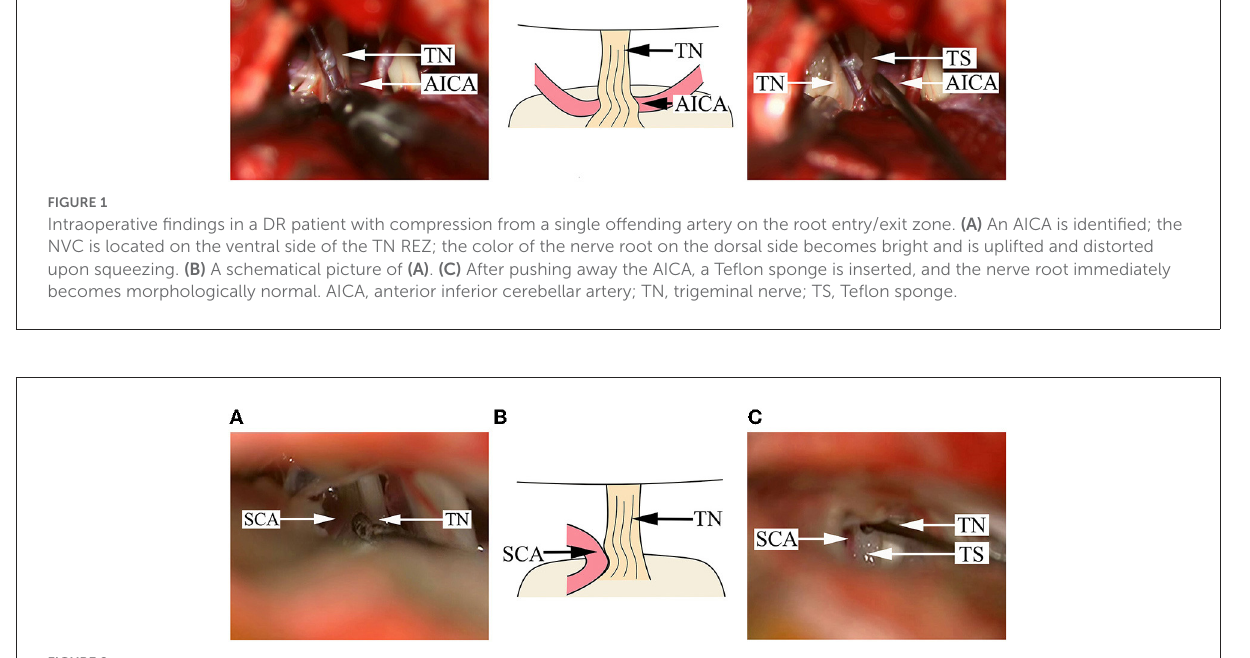
FIGURE2 Findings in a DR patient whose cisternal segment of TN is compressed by the offending artery. (A) A SCA is impacted into the cisternal segment of TN, and the color of the TN root becomes dark, seriously deformed and depressed. (B) A schematical picture of (A) . (C) After pushing away the SCA, a Teflon sponge is placed between the artery and the TN root. SCA, superior cerebellar artery; TN, trigeminal nerve; TS, Teflon